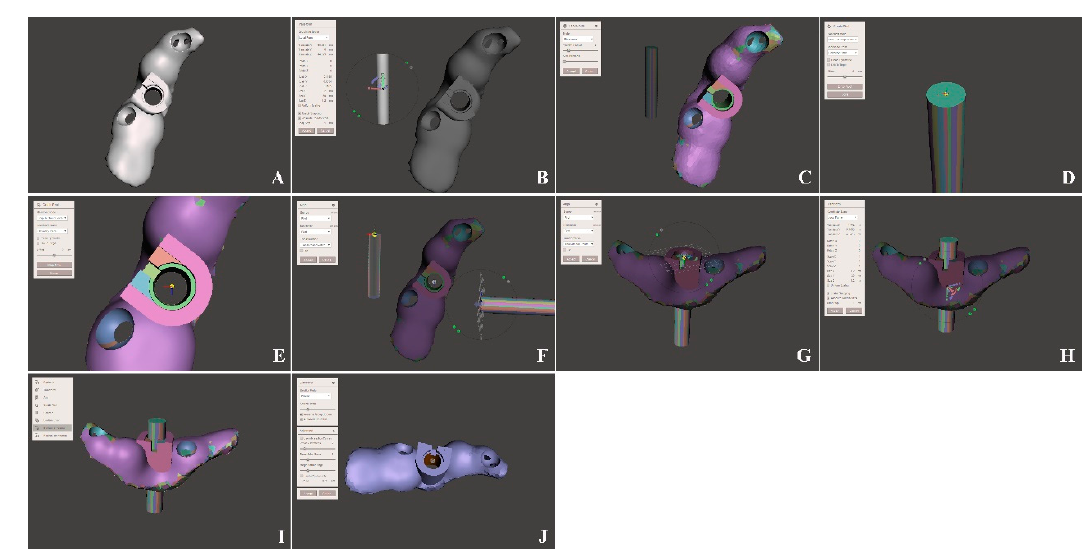
Figure 3. Method to adjust the size of the guide hole using Meshmixer. ( A ) Importing virtual surgical guide. ( B ) Creating a cylinder. ( C ) Partial segmentation of the cylinder and surgical guide. ( D ) Setting a reference point at the base of the cylinder. ( E ) Setting a reference point in the guide hole of the surgical guide. ( F ) Alignment with the cylinder and surgical guide. ( G ) Identification of alignment. ( H ) Cylinder movement. ( I ) Deletion of the overlapping parts of the cylinder and surgical guide. ( J ) Identification of the adjusted guide hole.